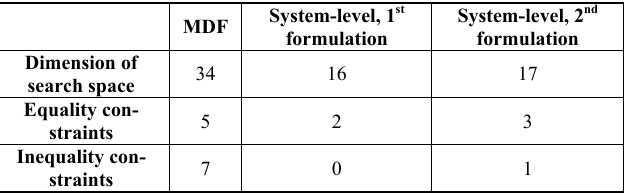
Table 4. Comparison of MDF and stage-wise